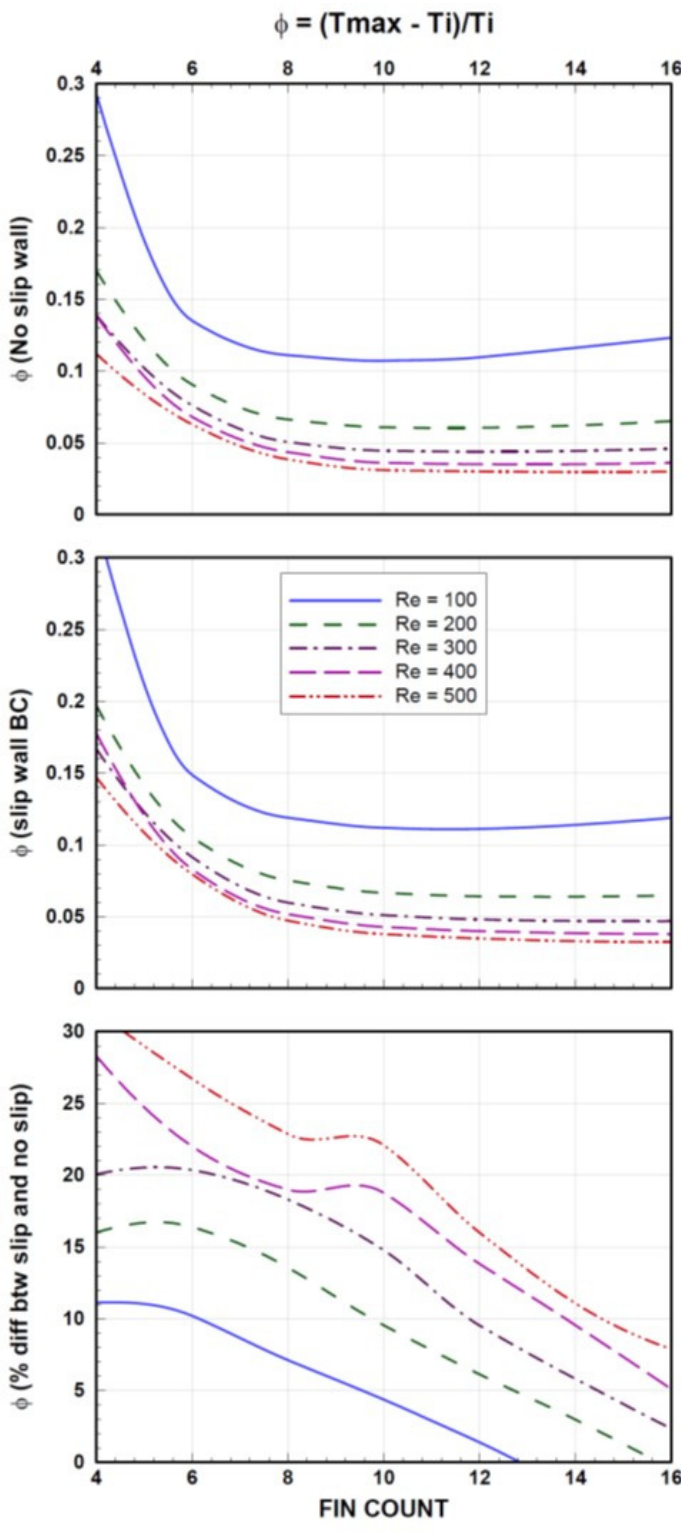
Figure 7. Temperature parameter ( 𝜙 = ((cid:3021) (cid:3288)(cid:3276)(cid:3299) (cid:2879)(cid:3021) (cid:3288)(cid:3284)(cid:3289) ) , where Tmax is the maximum temperature and T min is the inlet port temperature)) with fin counts for various Reynolds numbers and hydrophilic and hydrophobic fin surfaces. % difference of temperature parameter is also given for comparison.